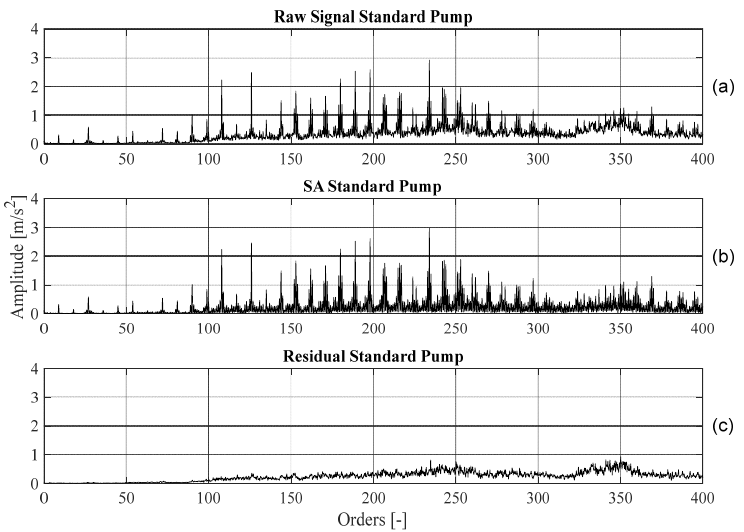
Figure 5. FFT of ( a ) acceleration signal, ( b ) synchronous average, and ( c ) residual signal for the signal acquired with sensor 1 in the case of flawless pump (1500 r/min, 150 bar).